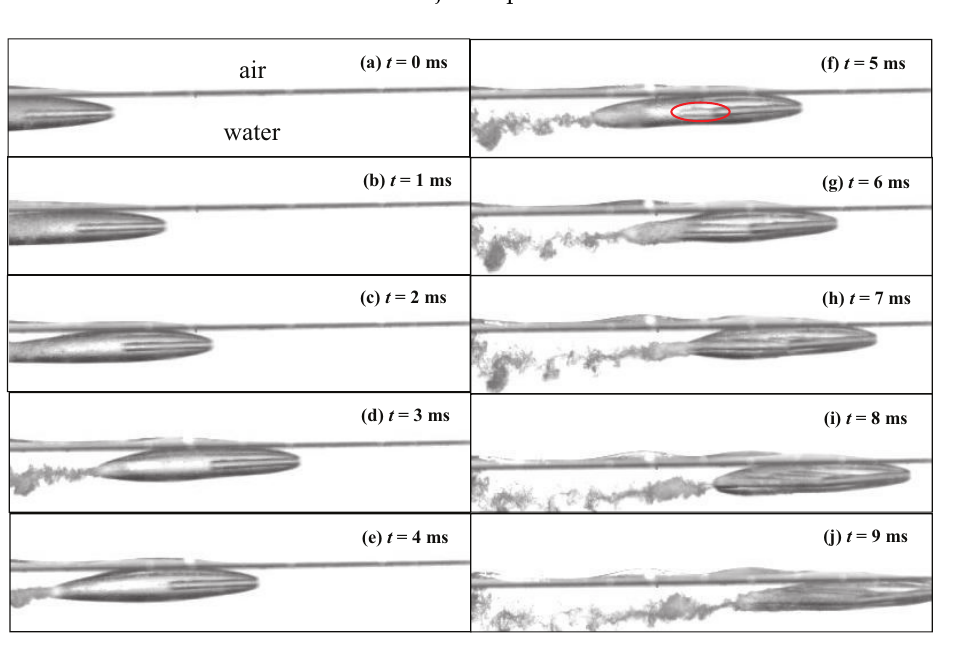
Figure 4. Supercavitation evolution of the projectile with hydrophobic coating at 3.33D water depth ( ∆ t = 1 ms, V 0 = 31.8